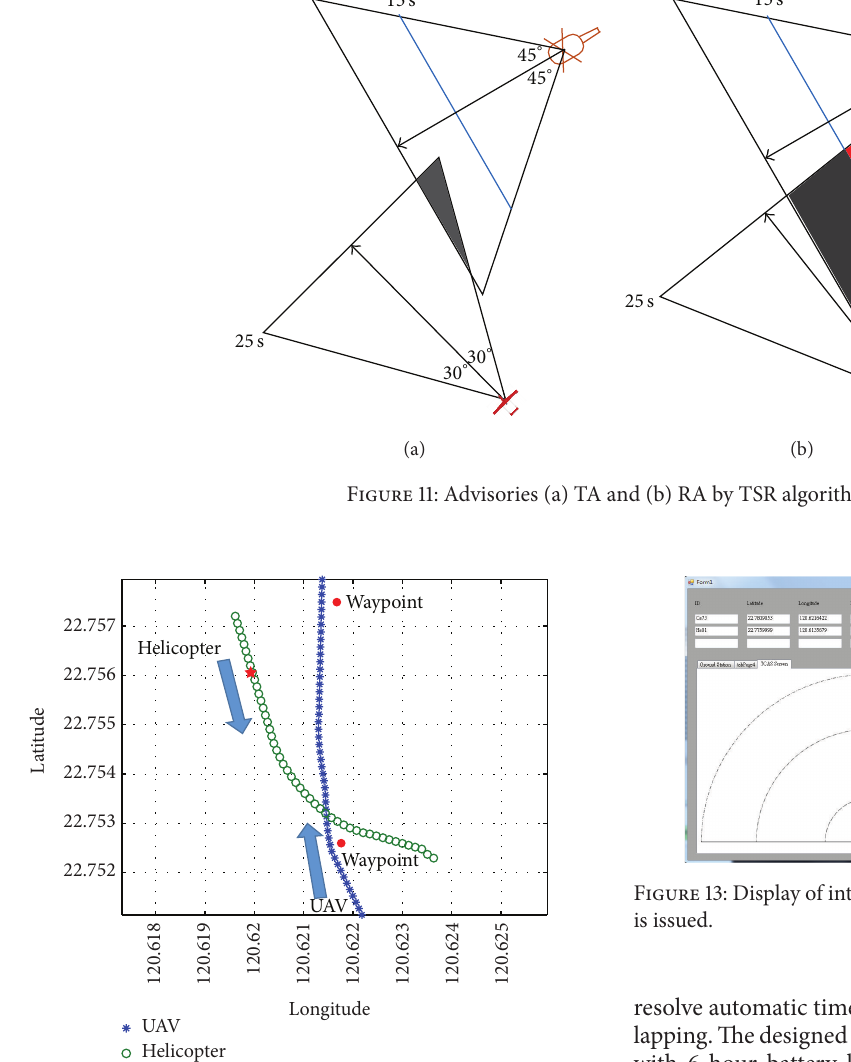
(800 ms ∼ 1000 ms). These slots are unused message slots used